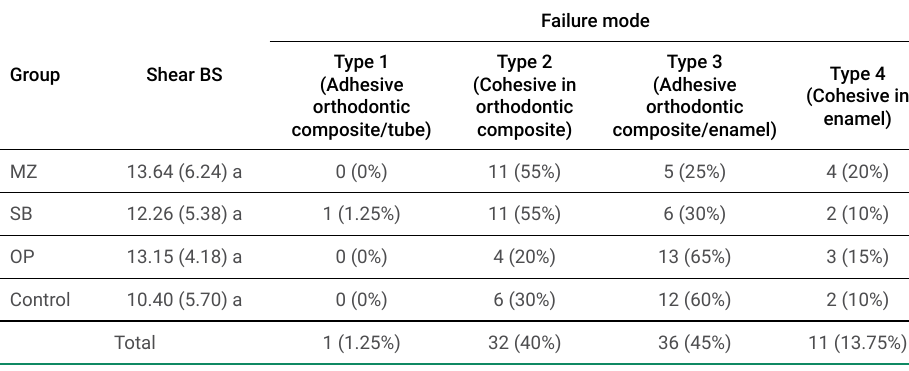
Table 3. Mean and standard deviation of shear bond strength and distribution of the failure mode according to treatments. Group